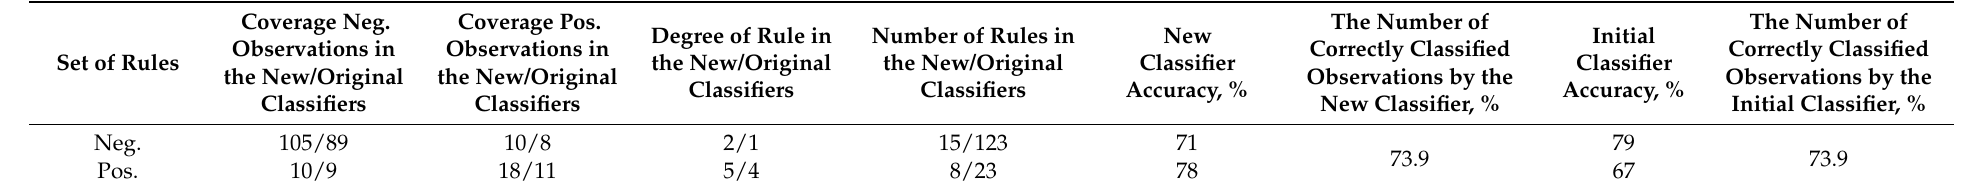
Table 4. Comparison of the classifier accuracy with different baseline observations to build patterns (the problem of predicting the outcome of a patient’ disease with